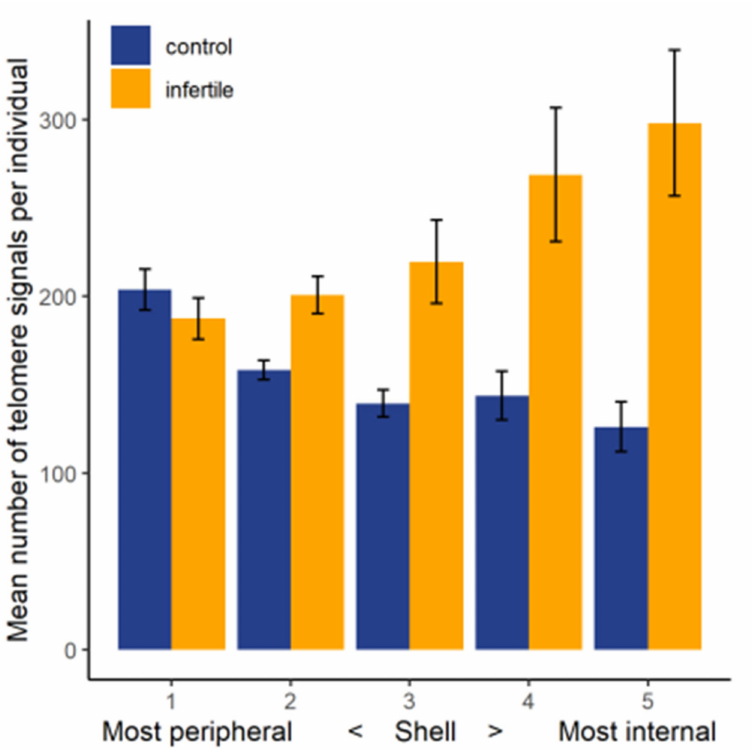
Figure 4. The total number of telomere signals per individual counted in each portion of the nuclear volume for control and infertile males. Shell 1 represents the outermost volume of the nuclei, while shell 5 represents the innermost volume of the nuclei. Error bars represent the standard error of the mean.